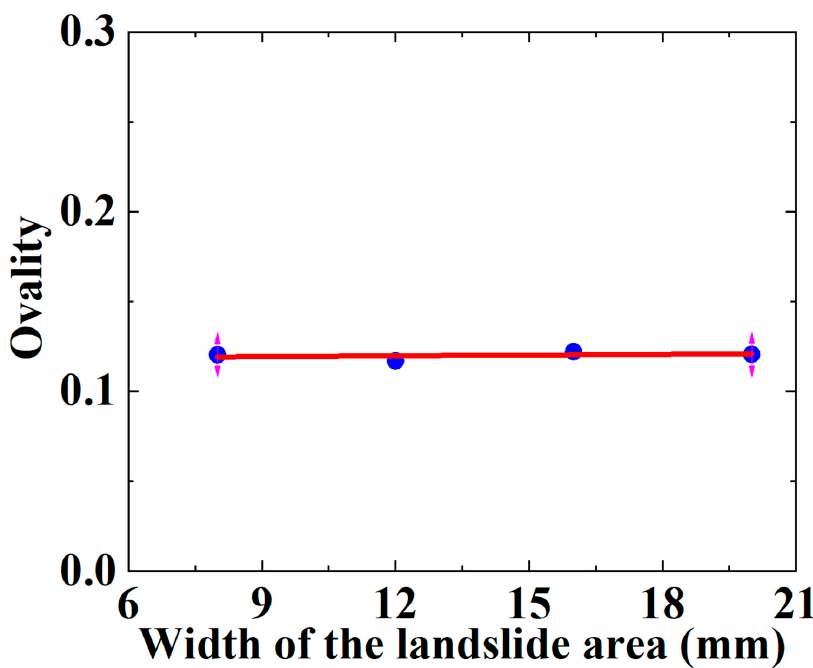
Figure 21. Variation in ovality δ of SWW-RTP with different landslide area widths when the HDPE begins to yield.